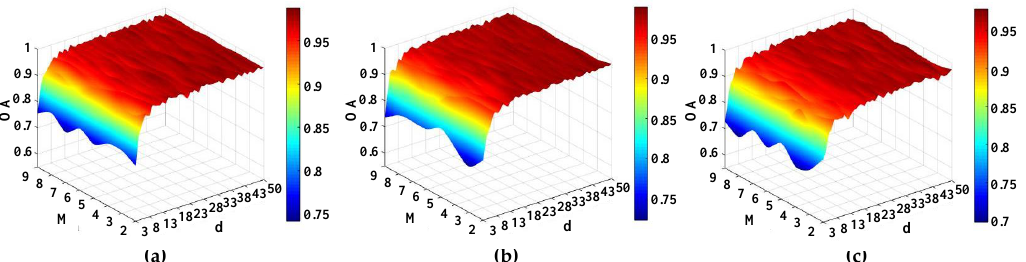
Figure 9. OAs versus the reduced dimensionality d and the number of mixture components M in the proposed methods with SVM classifier on the Indian Pines dataset. ( a ) MFA ( b ) SMFA, and ( c ) DMFA in the first